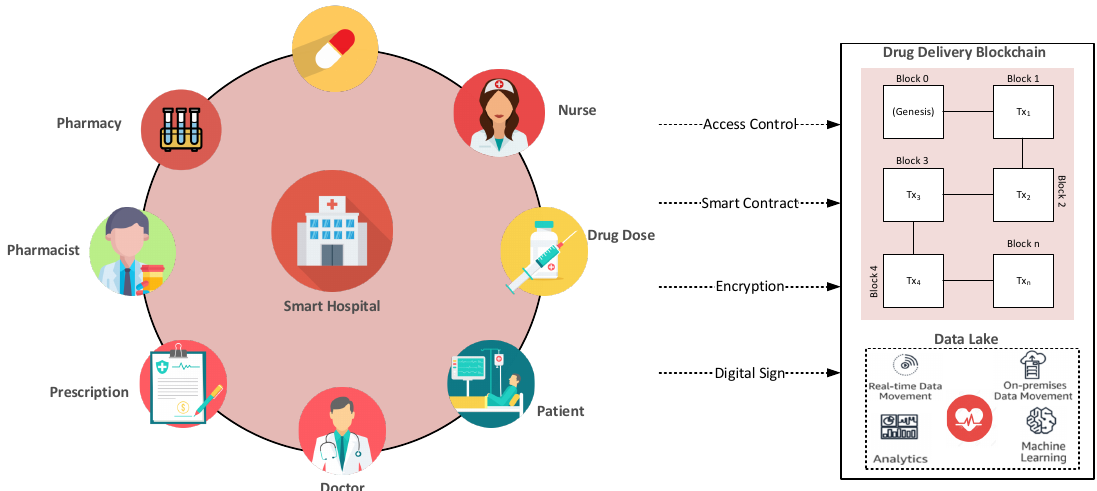
Figure 2. Scenario of drug delivery supply chain management in a medical